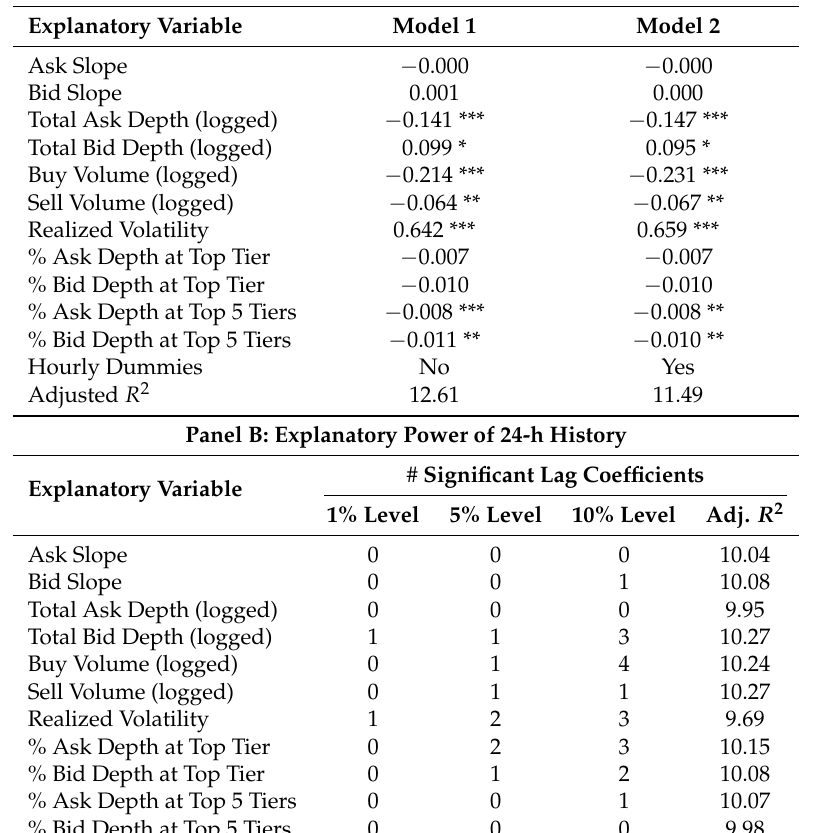
Table 5. Regression of price impact on limit order book state. Panel A reports the baseline regression of price impact on listed explanatory variables capturing the prevailing state of the limit order book. We estimate the regression without (Model 1) and with (Model 2) hourly dummies to account for possible diurnality of price impact. ∗∗∗ p < 0.01, ∗∗ p < 0.05, ∗ p < 0.1. Panel B shows the incremental explanatory power of the 24-h history of each explatory power. Each row in Panel B is based on the regression that augments baseline model 1 with 24 lags of the given explanatory variable. Reported are the number of lags with significant coefficient at the 1%, 5%, and 10% level, as well as the adjusted R 2 . Price impact (the dependent variable in all regressions reported in the table) is the price impact of order book events over each hour, estimated as described in the text. Data are from BTC-e for the period from 7 December 2013 to 24 September 2014. Panel A: Baseline Regression of Price